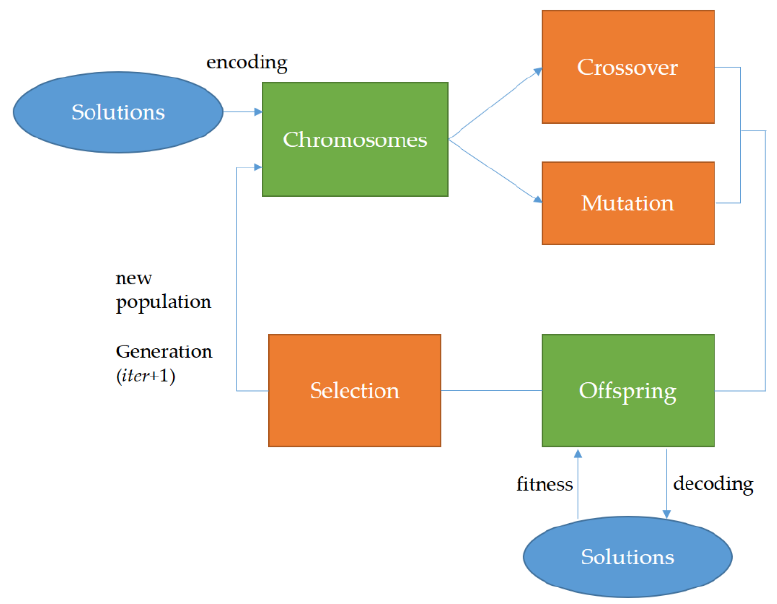
Figure 5. A typical evolutionary cycle of a genetic algorithm (GA).